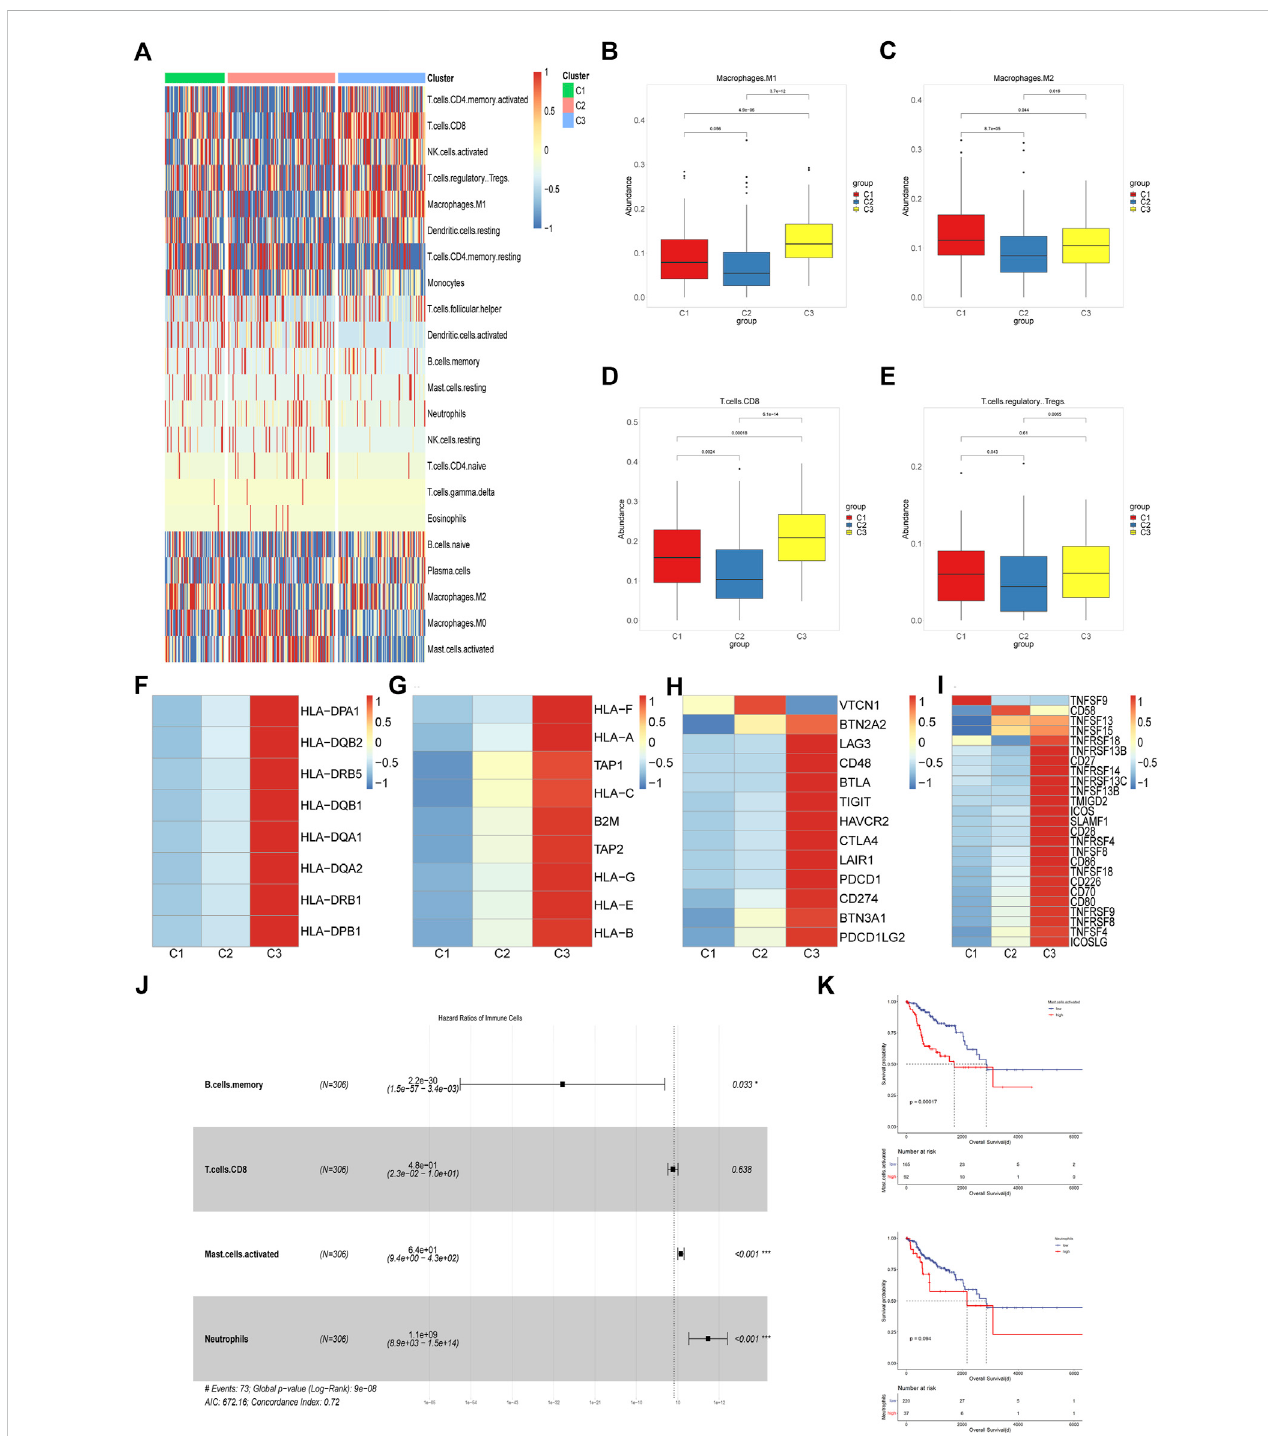
FIGURE 2 Characterization of the Immune Microenvironment Among Different Subpopulations (A) Heatmap of the abundance of 22 immune cells among three subgroups in TCGA cohort. (B – E) Boxplots of abundance of M1 macrophages, M2 macrophages, CD8 + T cells and Tregs among three different subtypes in TCGA cohort. The differences were compared using the Kruskal – Wallis test. (F,G) Heatmap of differential expression of MHC molecules among three subtypes in TCGA cohort. (H,I) Difference of co-stimulatory and co-inhibitory molecules expression level in three subtypes. (J) Multivariate cox regressionmodel constructed basedon theimmune cellswith prognostic valueinunivariatecox analysis. (K) Kaplan-Meier curves ofoverall survival between cohorts in TCGA with high and low abundance of activated mast cells and neutrophils in fi